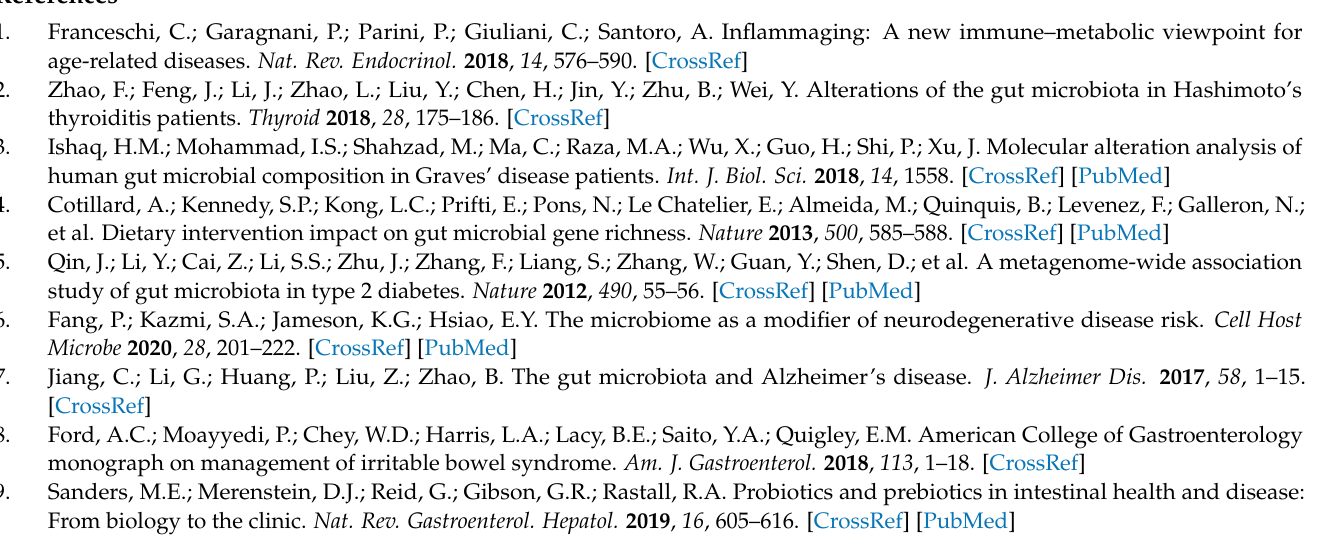
Table S2: Primers pairs employed for PCR and qPCR reactions and quantifications, Table S3: MANOVA categorical descriptors for the volatilome, categorized for the type of matrix, Table S4: MANOVA categorical descriptors for the volatilome, categorized for the time of fermentation, Figure S1: